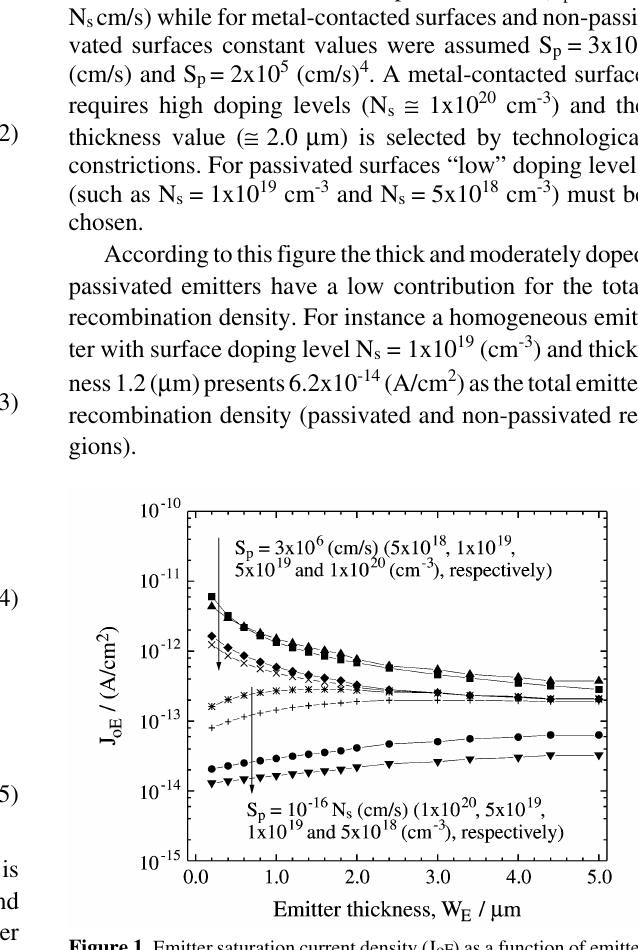
Figure 1. Emitter saturation current density (J oE ) as a function of emitter thickness (W E ), considering two kinds of surfaces: metal-contacted and passivated